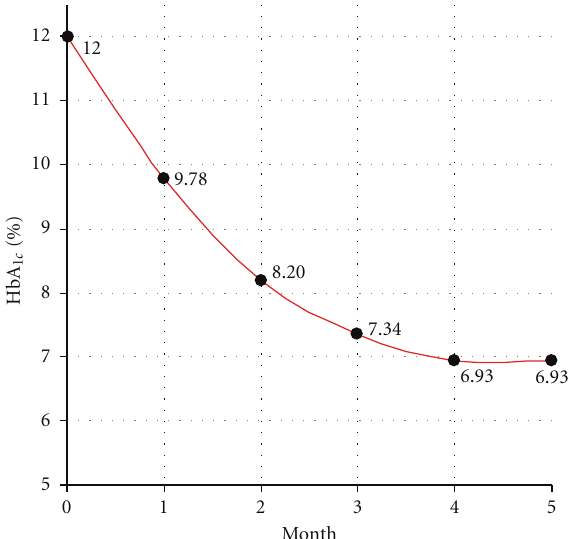
Figure 4: Changes in HbA 1c versus time for the patient presented in Example 2.